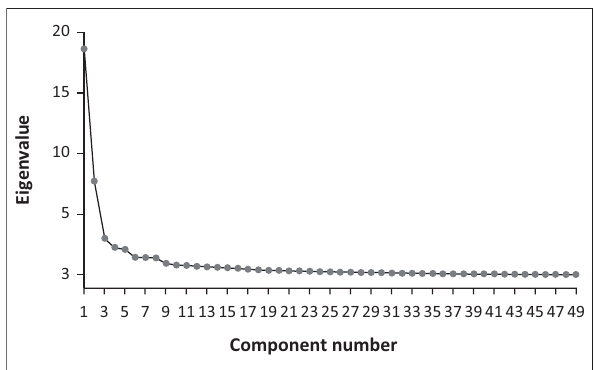
FIGURE 2: The scree plot and eigen-values used to extract endogenous